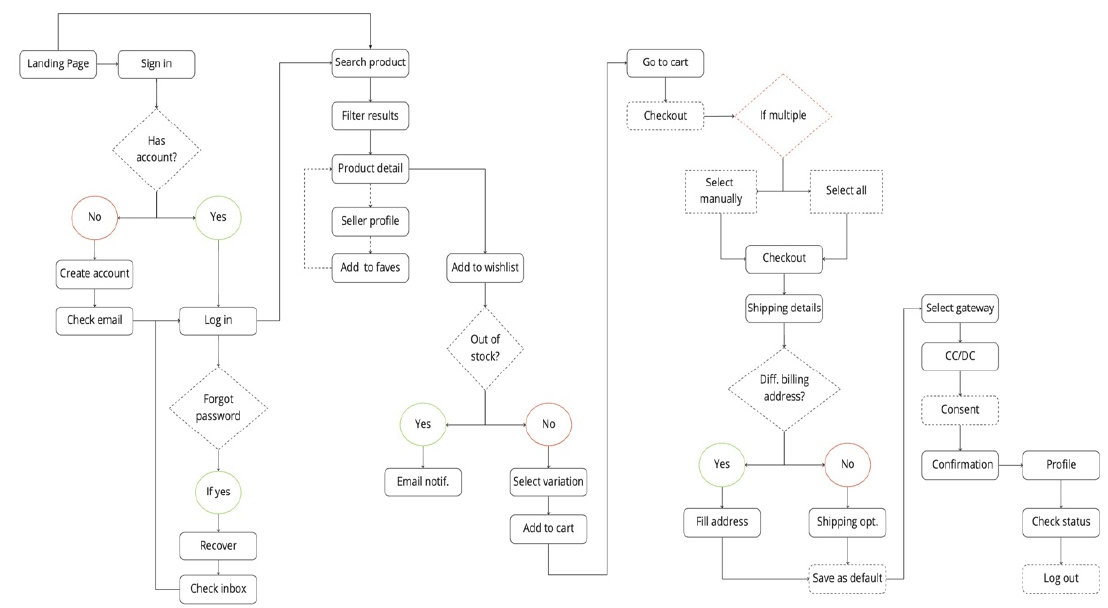
Figure 4. User flow for buyers’ prototype. Self-source, 2020.